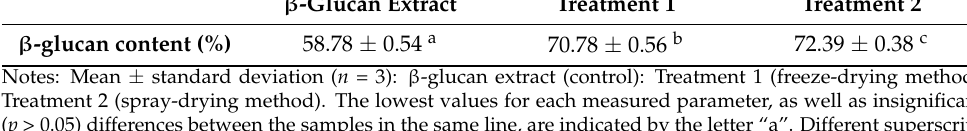
Table 2. Determination of β -glucan content. β -Glucan Extract